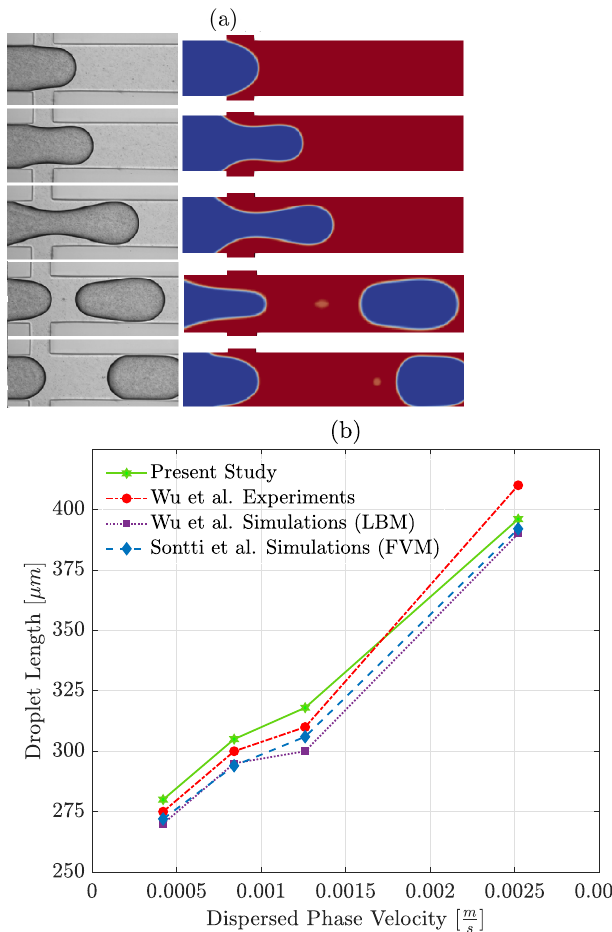
Figure 5. ( a ) Comparison of droplet formation steps for µ d = 1.074 × 10 − 2 Pa · s and ρ d = 1.03 × 10 3 kg/m 3 , µ c = 2.441 × 10 − 2 Pa · s and ρ c = 0.93 × 10 3 kg/m 3 , U c = 0.00256m/s, U d = 0.00084m/s, σ = 0.03N/m; left: Wu et al. [41] experiments (reprinted with permission from the publisher, Elsevier), and right: present simulation. ( b ) Comparison of droplet length predic- tions against the experimental and numerical results of Wu et al. [41] and Sontti et al. [21] for U c = 0.00252m/s, σ = 0.03N/m and µ d / µ c =